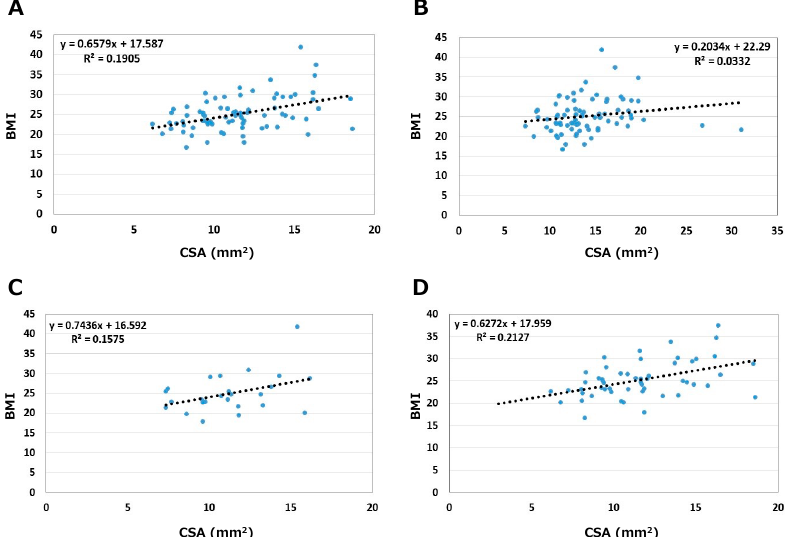
Figure 5. Relationships between BMI and CSA. ( A ) Asymptomatic side. ( B ) Symptomatic side. ( C ) Male. ( D ) Female. Correlation coefficients between median nerve CSA and disease duration were − 0.14 on the asymptomatic side and -0.08 on the symptomatic side. There was no correlation between median nerve CSA and disease duration on both sides ( p = 0.24 on the asympto- matic side and p = 0.51 on the symptomatic side). Correlation coefficients between median nerve CSA and distal latency of the EDX were 0.13 on the asymptomatic side and 0.08 on the symptomatic side. Correlation coeffi- cients between median nerve CSA and sensory nerve conduction velocity of the EDX were 0.19 on the asymptomatic side and 0.15 on the symptomatic side. No correlations were observed between median nerve CSA and the results of EDX on both side ( p > 0.05). 4. Discussion In the present study, median nerve CSA was significantly larger on the symptomatic side. Furthermore, weight/BMI correlated with median nerve CSA on the asymptomatic side. On the other hand, physical characteristics did not correlate with median nerve CSA on the symptomatic side. No significant differences were observed in CSA between the sexes even though physical characteristics significantly differed. US on median nerve CSA have been compared between healthy controls and patients with peripheral neuropathy. A systematic review reported a mean normative reference value of 8.74 mm 2 for median nerve CSA at the CT entrance, which is approximately the same site as the wrist crease assessed in the present study (n = 1863) [29]. Furthermore, the systematic review found no correlation between age or sex and reported a value for median nerve CSA at the CT inlet that appeared to be similar between each region. On the other hand, individual and site-specific differences in median nerve CSA were not small. Among studies measuring normal median nerve CSA at the CT inlet level, individual val- ues widely ranged between 7 and 10 mm 2 (lower and upper bounds of 95% CI, respec- tively) [29]. Nakamichi et al. measured the median nerve CSA of CTS patients at three different levels (the distal edge of the flexor retinaculum, the hook of the hamate, and at the wrist crease) and suggested that the median nerve had an hourglass-like shape [30]. Since there are large individual differences in normal values and CSA values vary de- pending on the measurement site, this study was validated by the difference in median